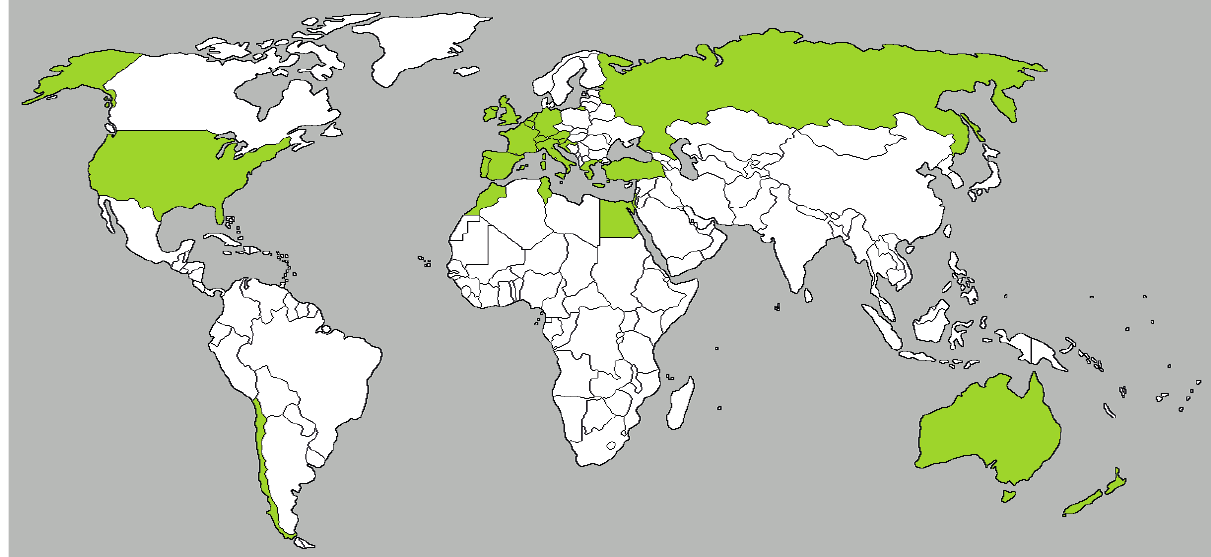
Figure 1. Countries that have expressed interest to participate in at least one of the research projects commissioned through Euphresco on research priorities for the Mediterranean